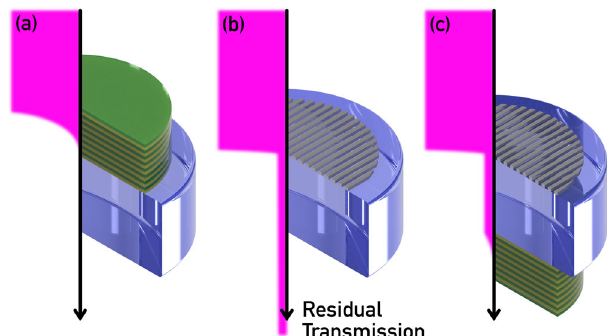
Fig. 2 Scheme of the different mirror technologies. a Conventional Bragg Mirror, b Meta-Mirror, c Meta-Etalon. The pink color indicates the intensity distribution in front of, inside and behind the